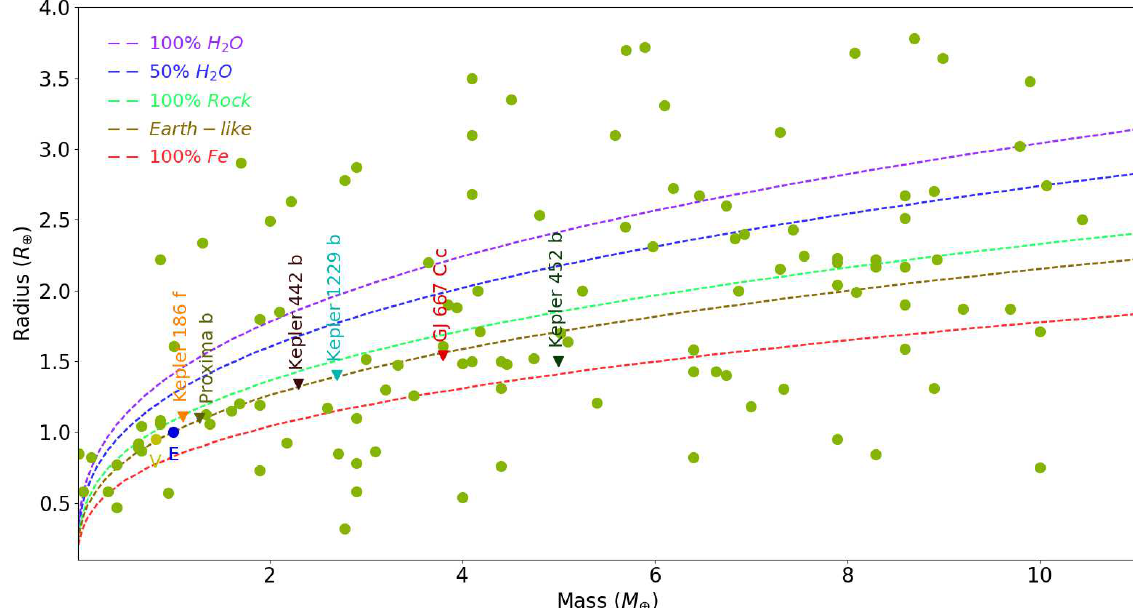
Figure 1. Mass-radius relationship. Earth-like planets have ~68% silicate mantle and ~32% iron core. The percentage of iron in the den- sity profiles corresponds to the CMF. The percentage of water corresponds to the IMF. Extrasolar planets with known mass and radius and within the mass range of SEs are shown (green dots). There are also shown some of the most promising SEs in terms of posibilities of habit- ability